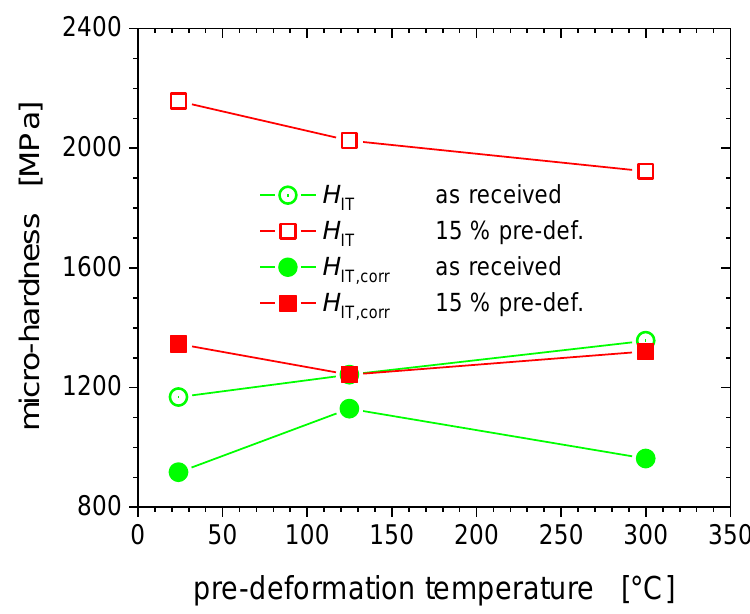
Figure 12. Hardness as a function of the pre-deformation temperature.